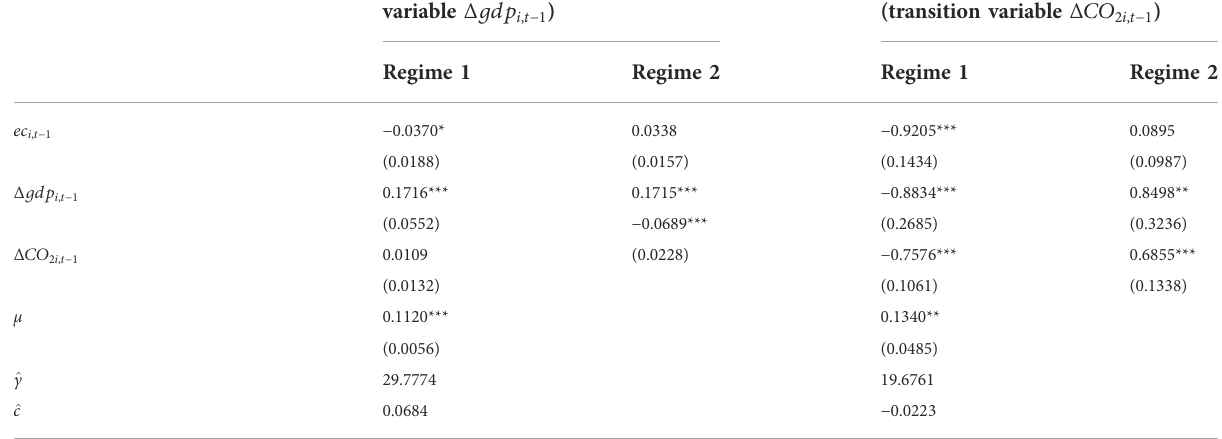
TABLE 6 Estimated Parameters of the PSTRVEC model.